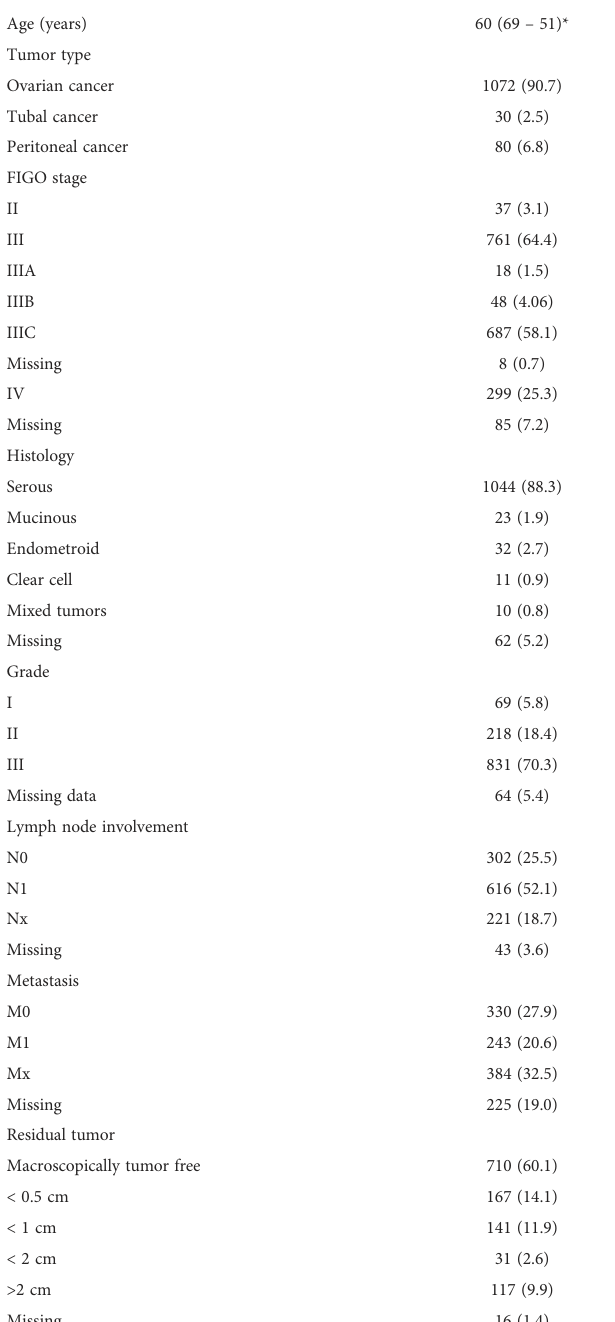
TABLE 1 Clinical characteristics of the patients (n=1182).